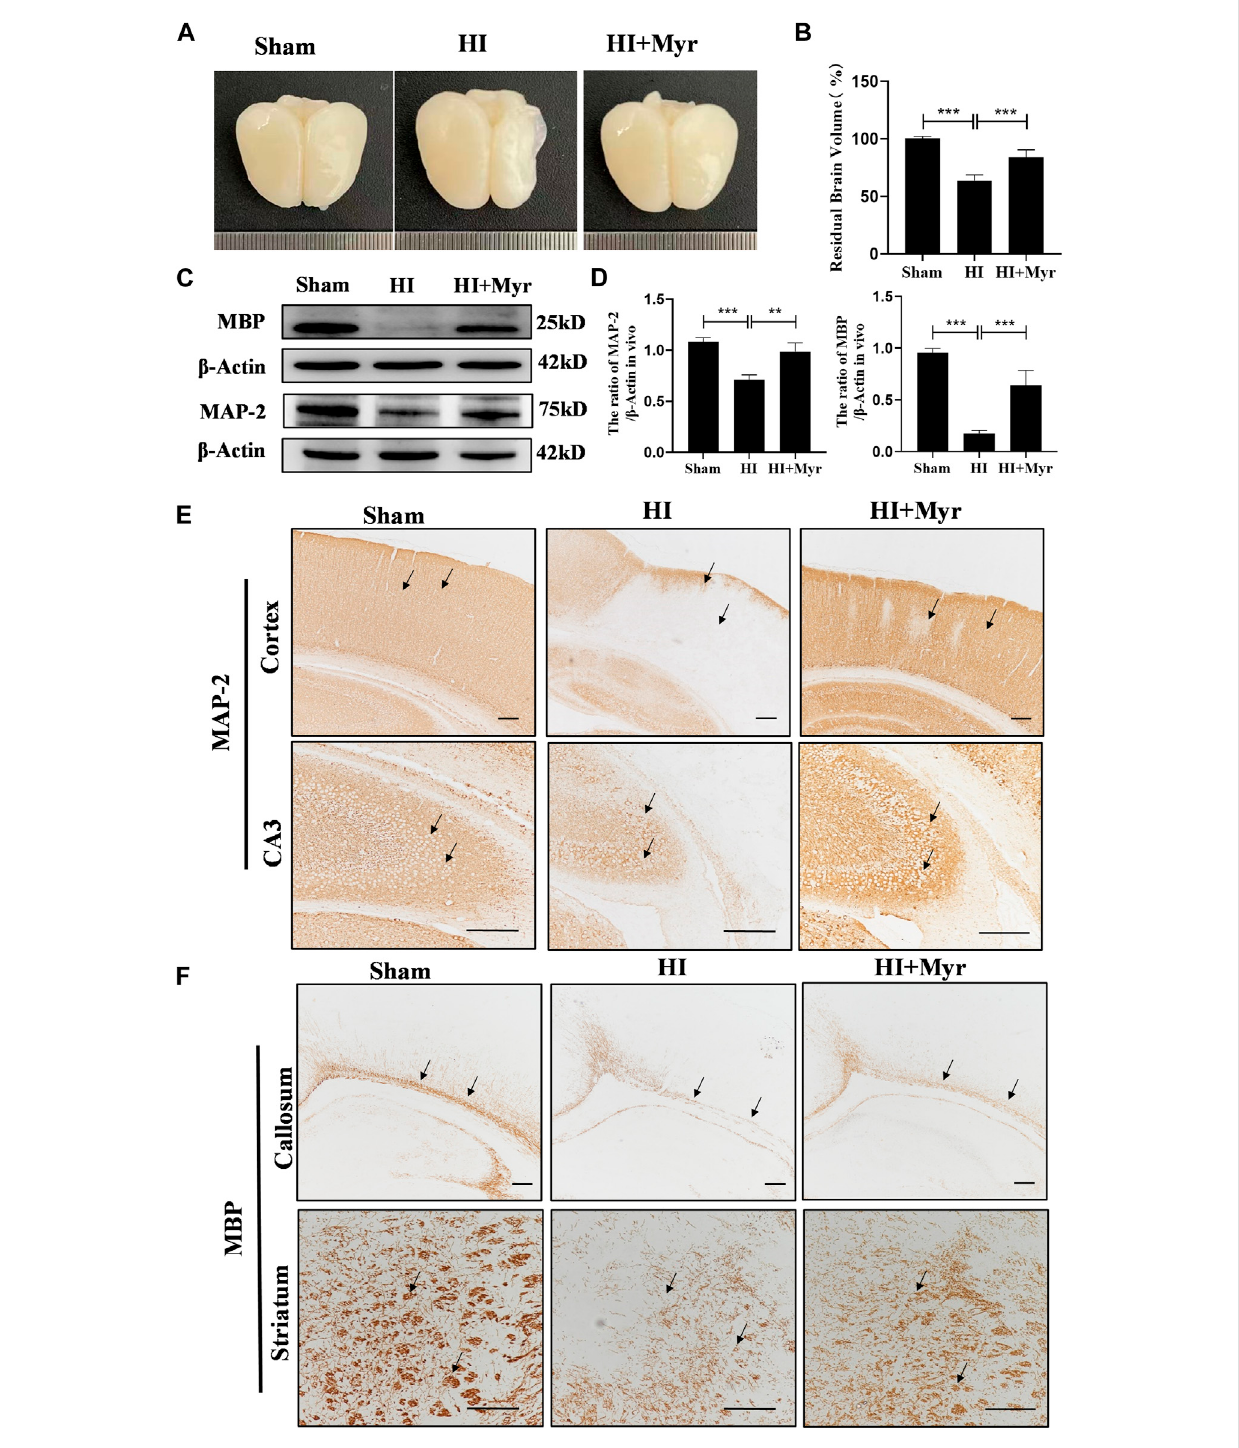
FIGURE 2 Myricetin alleviated brain atrophy and promoted white matter recovery. (A) The representative images of the brain from each group 7 days after HI brain injury. (B) Quantitative analysis of residual brain volume ( n = 6 per group). (C) The protein bands of MAP and MBP were detected by Western blot 7 days after HI brain injury. (D) Quantitative analysis of Western blot bands ( n = 4 per group). (E) The immunohistochemical staining of MAP-2 in brain cortex and hippocampal CA3 region 7 days after HI brain injury. Black arrows: indicate the density difference of MAP-2. (F) The immunohistochemical staining of MBP in brain callosum and striatum region 7 days after HI brain injury. Black arrows: indicate the density difference of MBP. The data are presented as mean ± SD. ** p < 0.01, *** p < 0.001. Scale bar: 200 μ